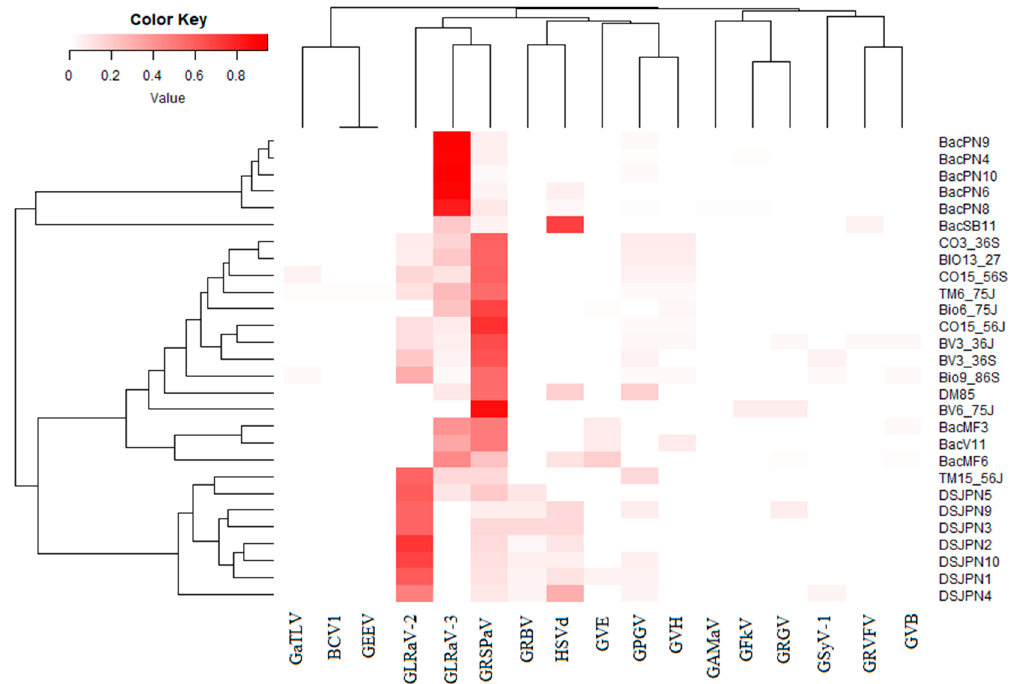
Figure 5. Heatmap of hierarchical clustering of grapevine virome composition profiles represented by the normalized relative abundance per grapevine sample. Heatmap color (white to dark red) displays the row-scaled relative abundance of each virus across all samples. The Bray–Curtis dissimilarity matrix and average linkage distance were used. R packages Vegan, Heatplus, gplots, RcolorBrewer and readxl were used (see materials and methods section for more details).